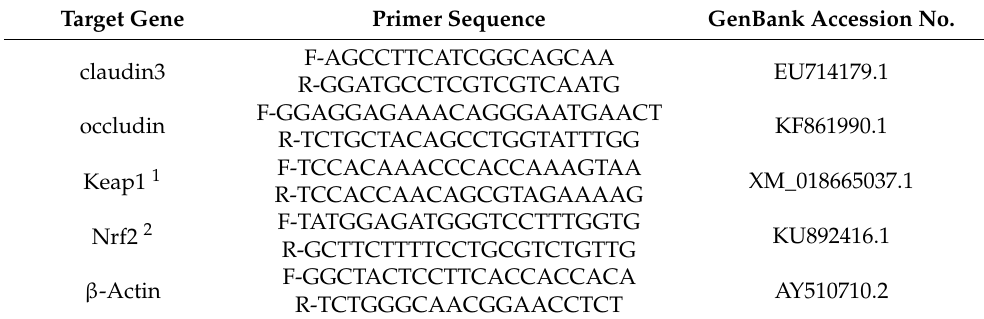
Table 2. The forward and reverse primers used for real-time quantitative PCR analysis and accession numbers of gene sequences